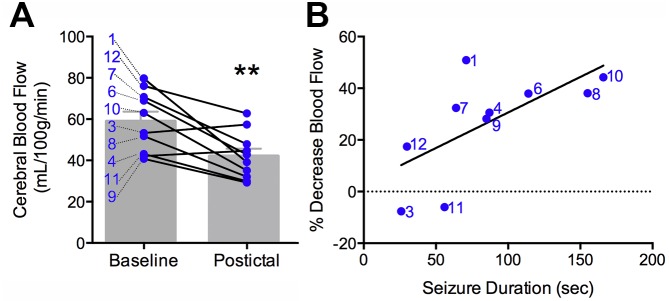
Clinical postictal hypoperfusion is more severe with longer seizures.(A) Cerebral blood flow from baseline and postictal ASL scans. Each point represents in individual. Group mean ± SEM are expressed in grey. Patient number is displayed on the left of the corresponding data point (e.g. one is patient ASL-001). A significant decrease in blood flow was measured in the postictal scan **p<0.01 (within-subject t-test). (B) Percent decrease in postictal blood flow as a function of seizure duration. A linear regression revealed a significant (p<0.05) positive correlation defined by the line y = 0.28x+3.12 (R square = 0.43).